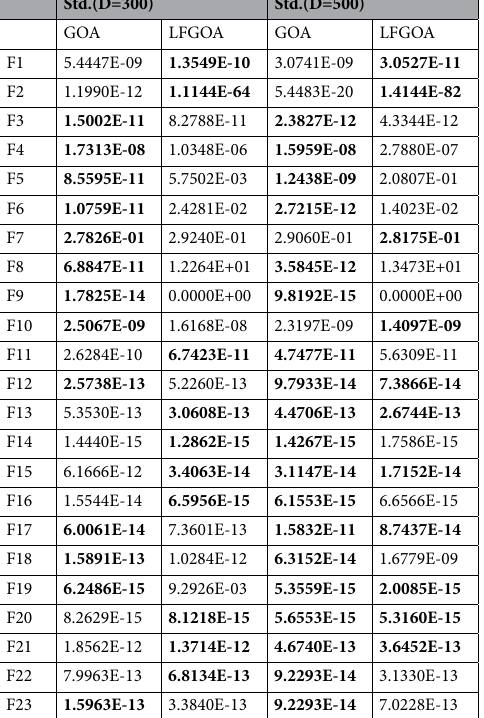
Table 12. The Std values of dimensions are equal to 300 and 500. The best of the comparison results are in [bold].